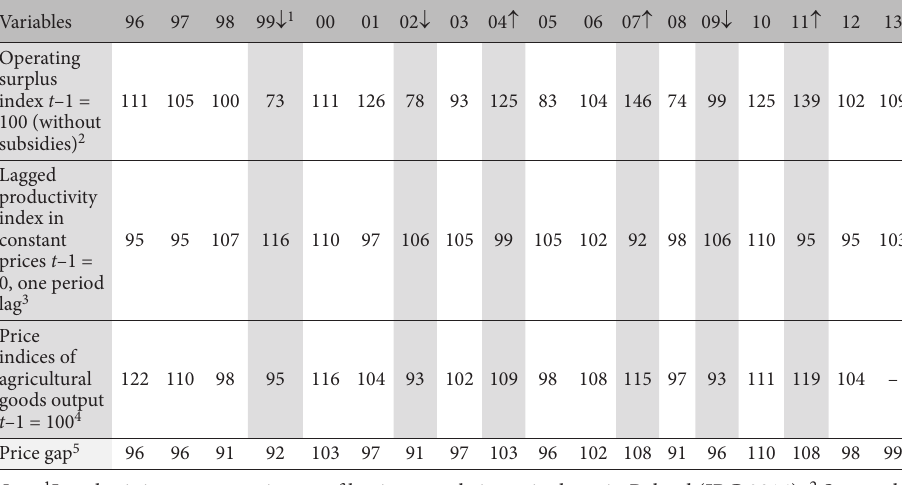
3 See methodology in Table 2; 4 Price indices of agricultural products – agricultural goods output, including fruits and vegetables; 5 Relation between the price index of products sold by individual farms and the price index of products bought at individual farms in Poland (inflation rate